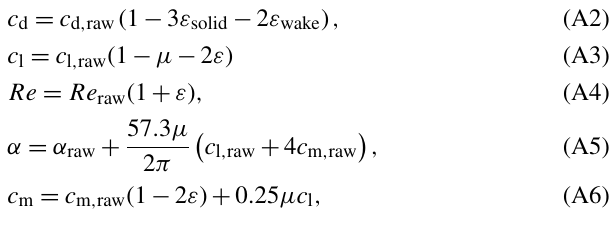
est MGF height of 0.25 % c in the tip region. The medium size MGF of 0.5 % c and the VG height of 1.1 % c are